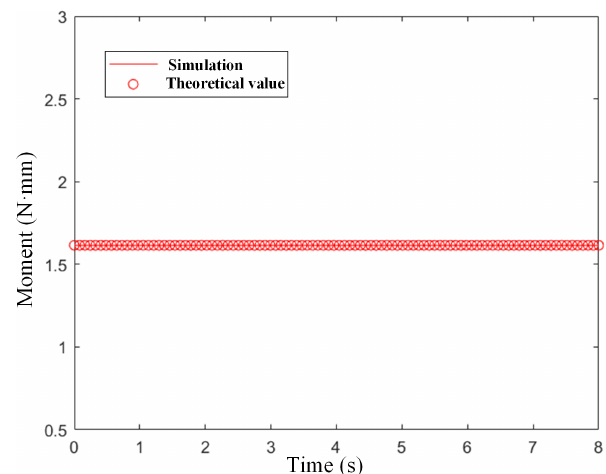
Figure 19. Driving torque.